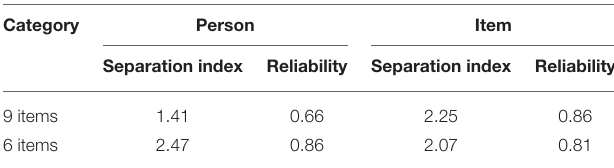
TABLE 5 | Person and item separation index of nine items and six items. Category Person